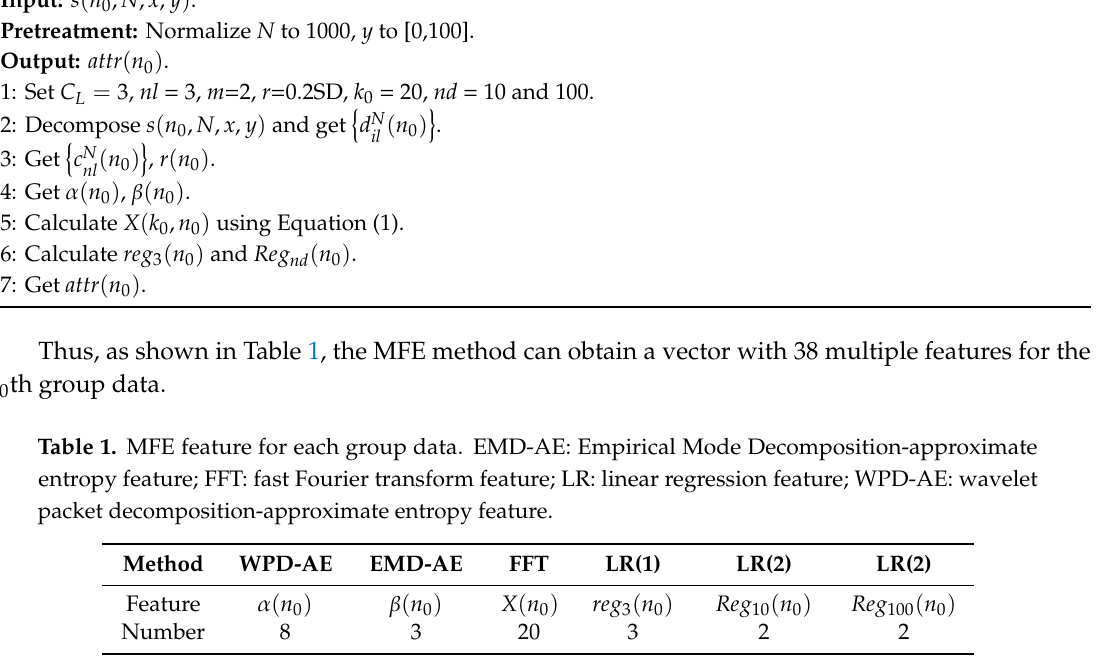
Algorithm 1. Method 1: MFE method